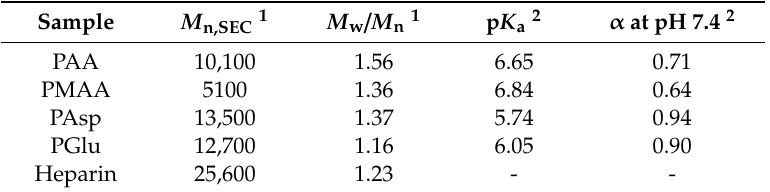
Figure 2. ( A ) Size exclusion chromatography (SEC) charts of polycarboxylates and heparin eluted with 100 mM NaNO 3 solution at 40 °C. ( B ) pH- α curves of polycarboxylates at 25 ± 1 °C. The plots represent poly(acrylic acid) (PAA, squares), poly(methacrylic acid) (PMAA, circles), poly(aspartic acid) (PAsp, triangles), and poly(glutamic acid) (PGlu, diamonds). Table 1. Characterization of polycarboxylates and heparin.